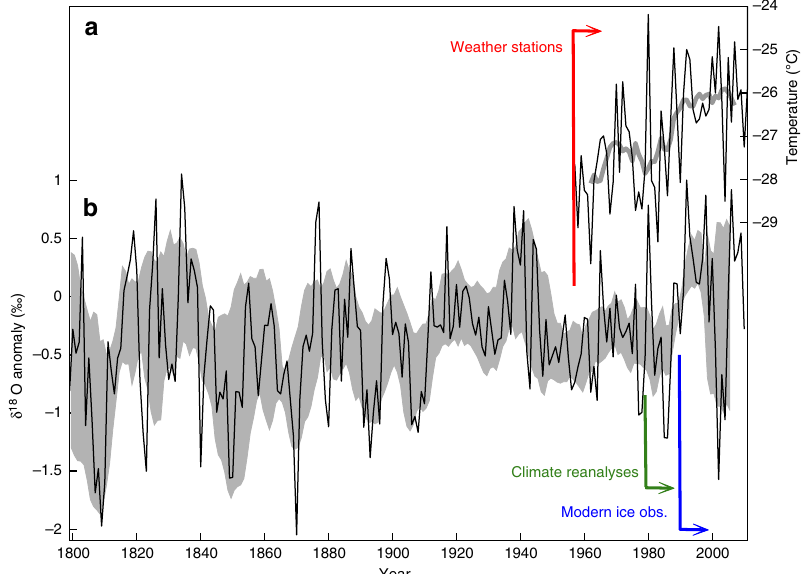
Fig. 1 West Antarctic climate variability over the last 200 years. a Mean-annual temperature data at the Byrd weather station. b Oxygen isotope ( δ 18 O) data from a collection of ice cores from the West Antarctic ice sheet. Gray shading shows decadal average with uncertainties. Vertical lines show the earliest year for which surface climate observations (red, 1957), climate reanalysis products (green, 1979) and spatially-complete geophysical ice-sheet observations (blue, ~1990) are available. Figure modi fi ed from Steig et al.